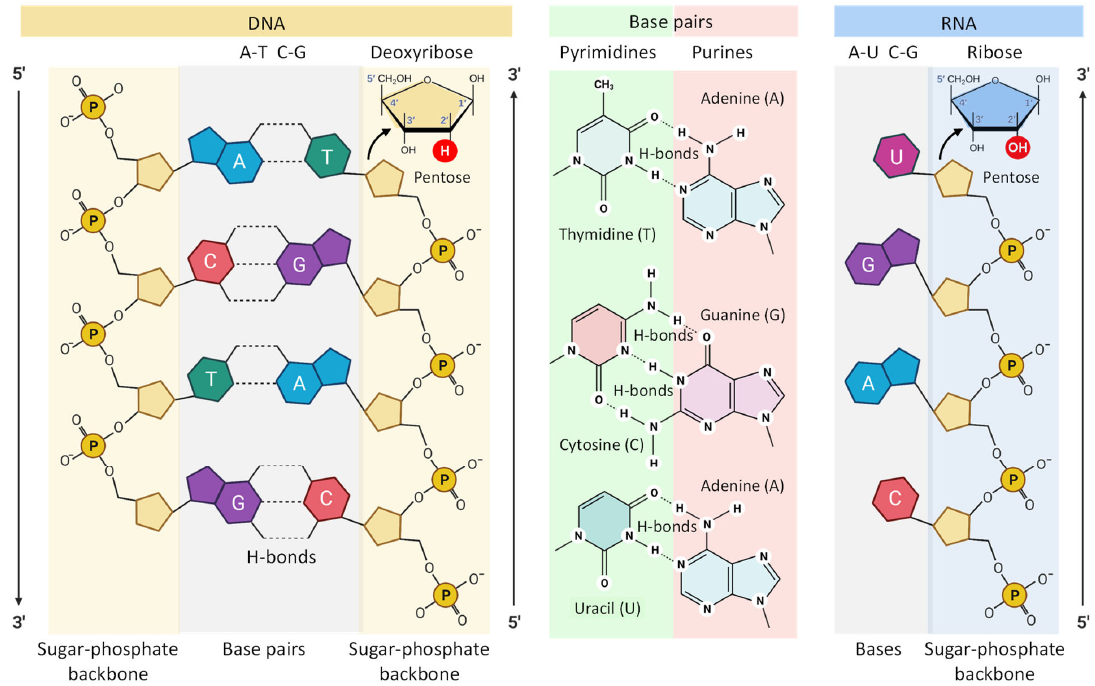
Figure 5. Molecular structure of DNA and RNA.